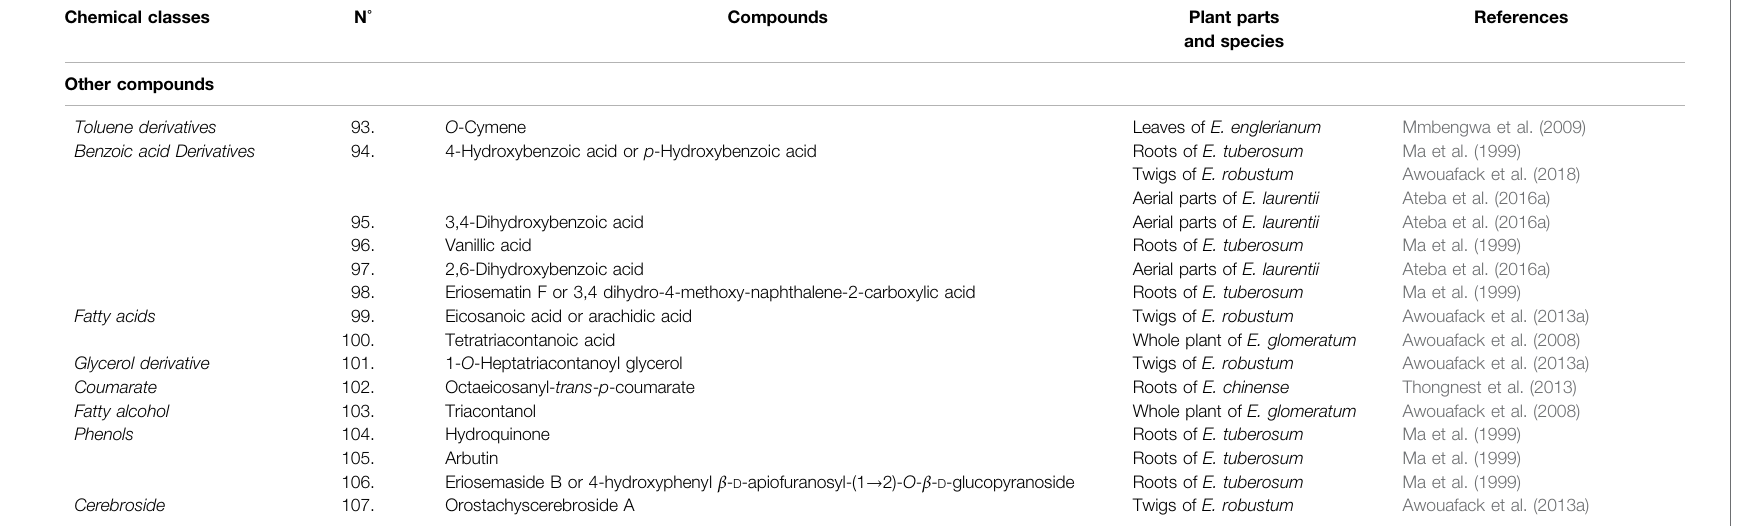
TABLE 3 | ( Continued ) Compounds isolated/identi fi ed from Eriosema species (the structure of compounds illustrated in Figure 2). Chemical